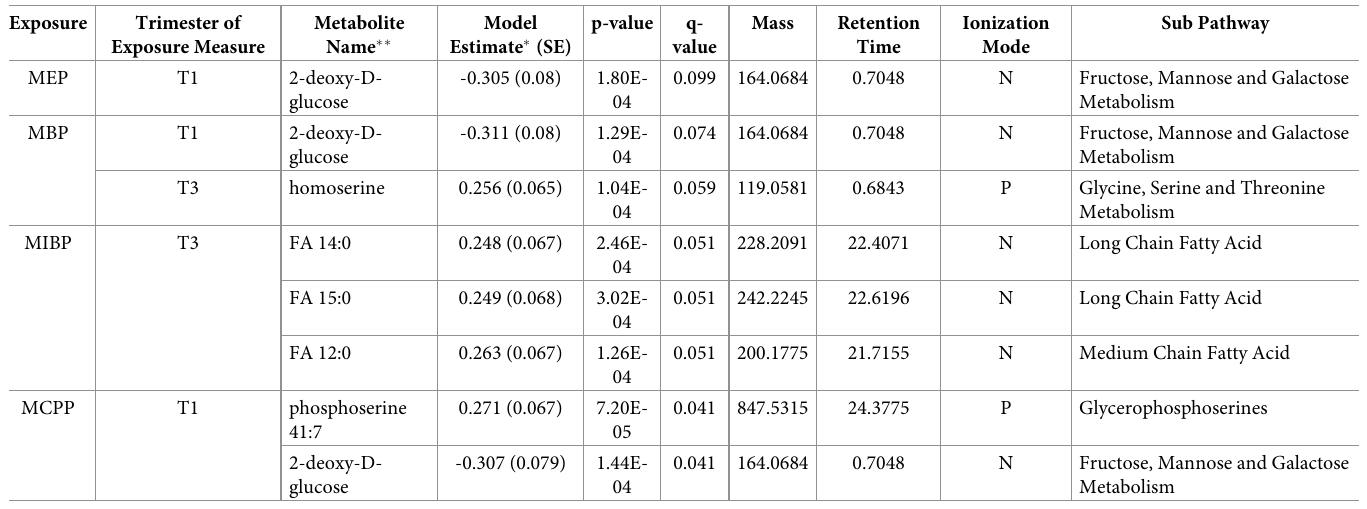
Table 2. Significant associations (q < 0.1) between maternal trimester-specific phthalates and metabolites among 234 children. Exposure Trimester of Exposure